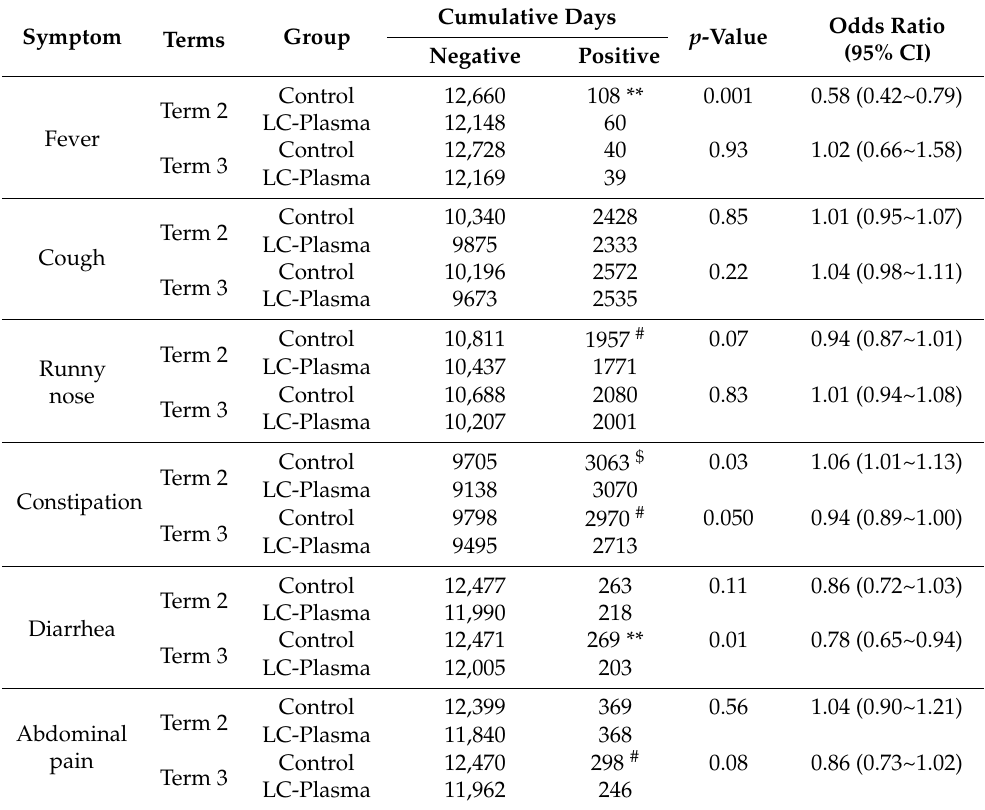
Table 3. Cumulative symptomatic days with URID and